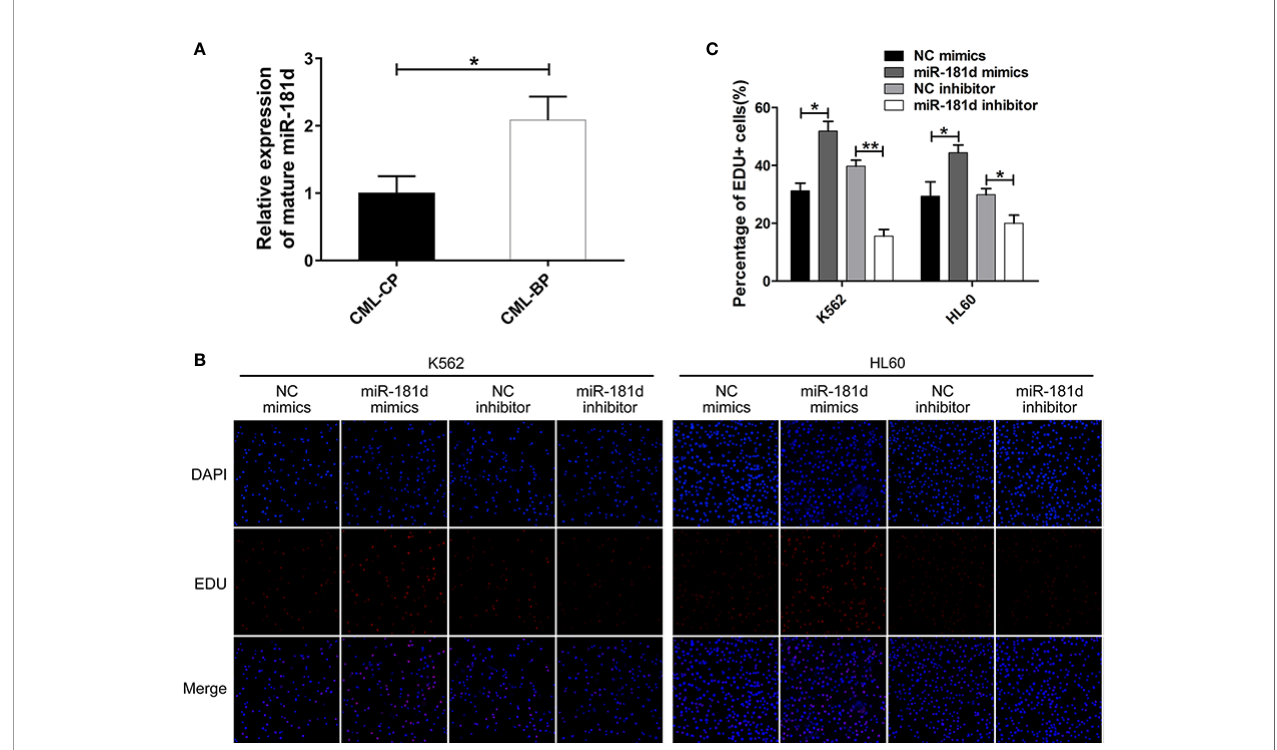
FIGURE 1 | miR-181d is overexpressed in CML-BP and promotes leukemia cell proliferation. (A) qRT-PCR analysis of mature miR-181d in CML-CP and CML-BP patients. Human CML-CP and BP cells were obtained from patients' bone marrow. (B, C) EDU of K562 and HL60 cells following transfection with miR-181d mimics or inhibitor. The results were con fi rmed by 3 independent experiments. * p < 0.05, ** p <